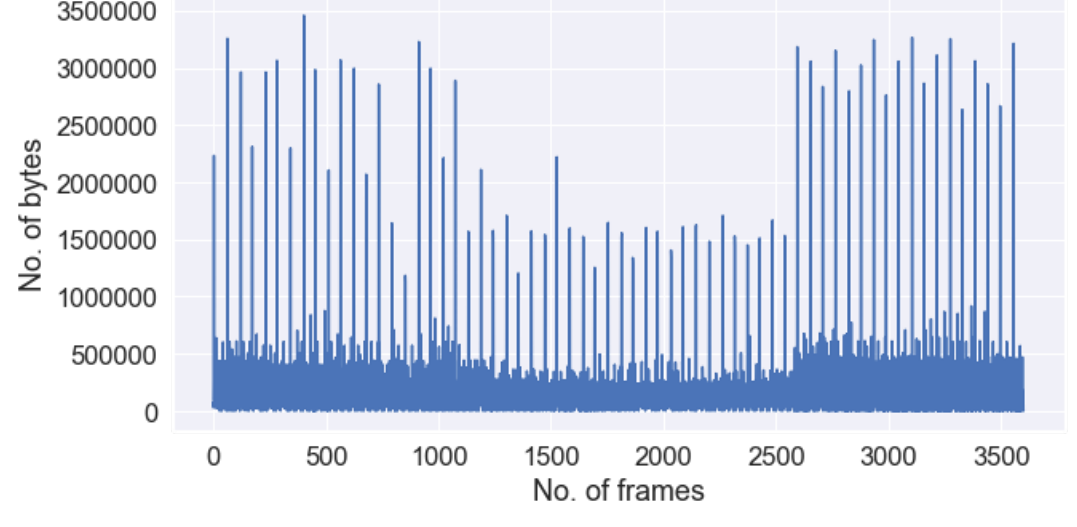
Figure 18b. Disk writes in S2.2.